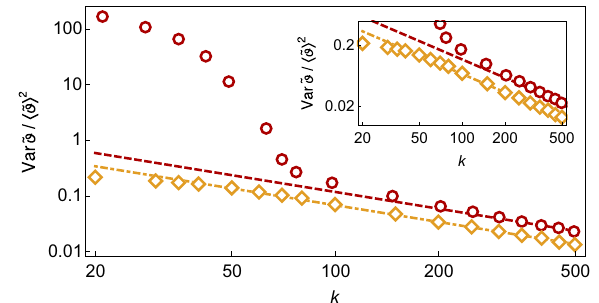
FIG. 4. Convergence of conventional and a priori optimized protocols. Log-log plot of variability versus the number of measurements k , calculated from 5000 simulated runs of the deep-trap experiment from Sec. IV B. The measurement count k excludes any calibration measurements at t = 0. Specifically, ( 2 / 7 ) k calibration outcomes are generated for each run. All other parameters are the same as in Fig. 3. The conventional non- linear-fit release-recapture (red circles) is compared to our a pri- ori optimized protocol (orange rhombs). Note the vast superiority of the optimized method for low k , i.e., scarce data. Asymptot- ically, the variability takes the approximate form 1 /( kF ) . This occurs for k > 350 for the conventional protocol and k > 200 for the optimized one. The dashed and dash-dot lines highlight the asymptotic variability scaling for both methods. The offset between these lines indicates that the asymptotic convergence speed to the true temperature is roughly twice as fast for the a pri- ori optimized protocol. The insets enlarges the region in which our Bayesian technique enters the asymptotic regime.